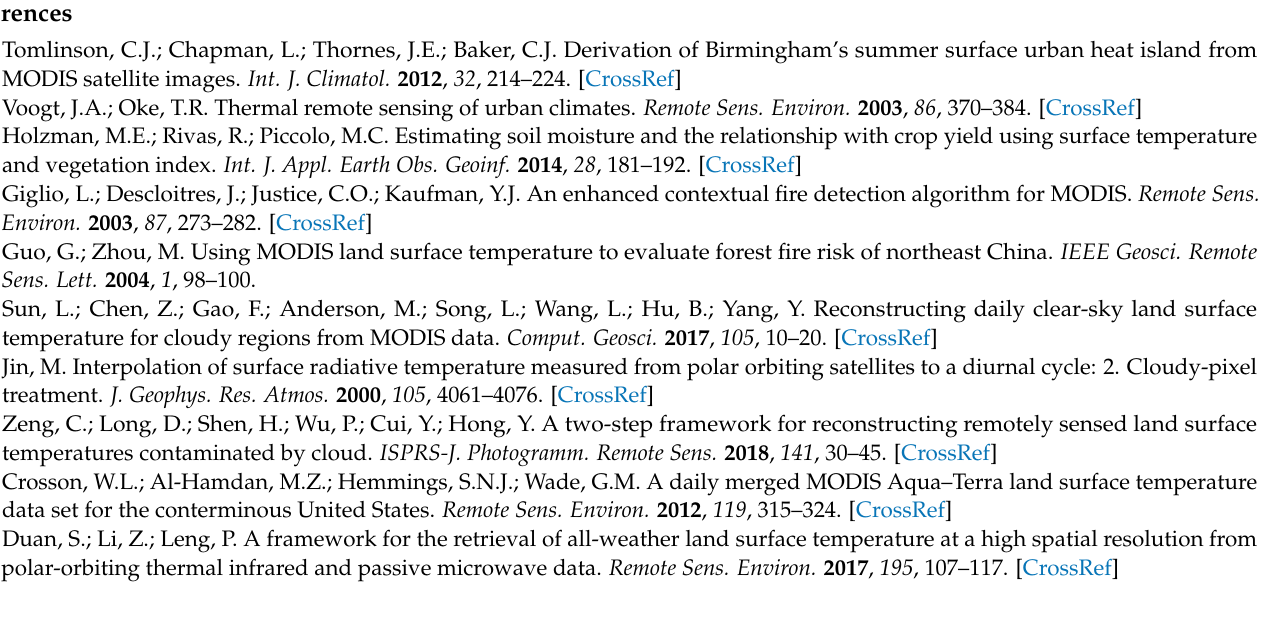
Figure A4. The performance of the ATC_GL with the LST missing time interval of one month (30 days).